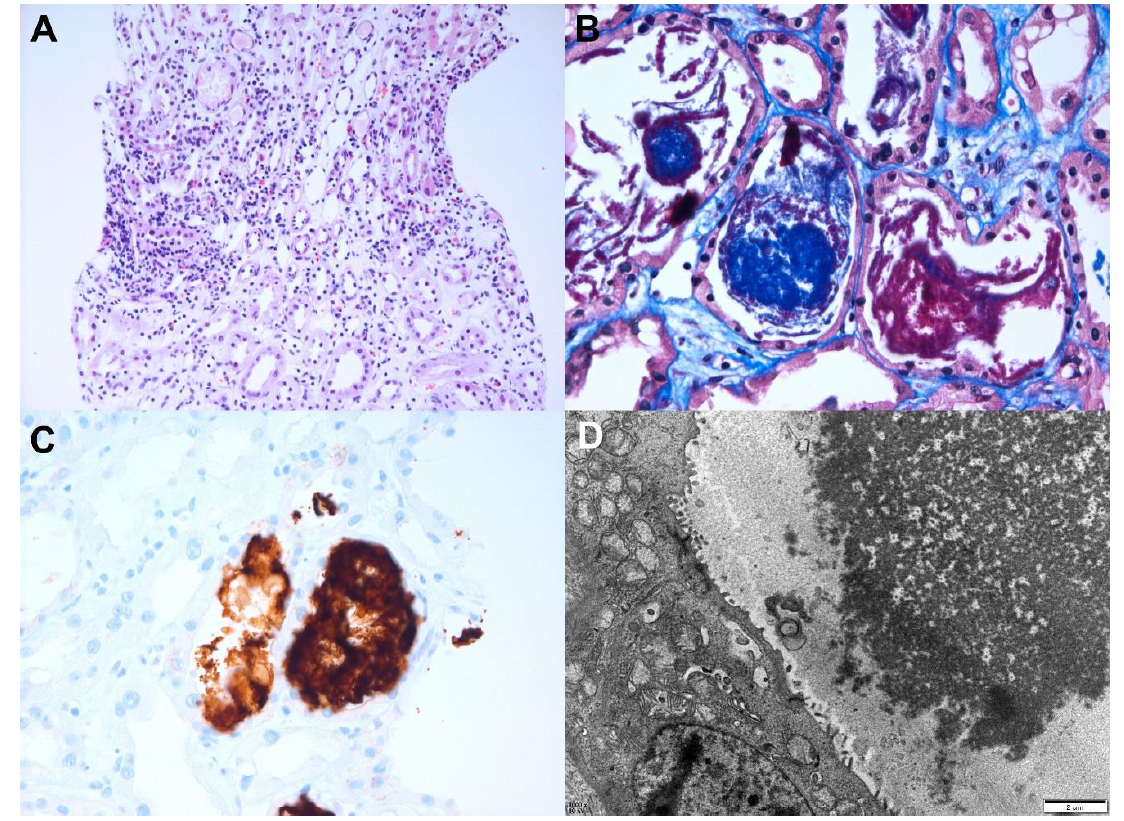
Figure 5. Pathologic findings of acute tubulointerstitial nephritis (patient 2). Light microscopy: ( A ) Mixed inflammatory cells infiltrated the tubular epithelium (tubulitis) and interstitium. Large numbers of mononuclear cells, neutrophils, eosinophils, and plasma cells were present (hematoxylin and eosin, ×400). ( B ) Acute tubular injury with red granular casts and string-like appearing casts was observed(Mas son’s trichrome, ×400) . ( C ) The casts show strong myoglobin positivity in the immunohistochemical stain (myoglobin, ×400). Electron microscopy: ( D ) The tubular casts have electron dense granules (×8000, 80 kv).